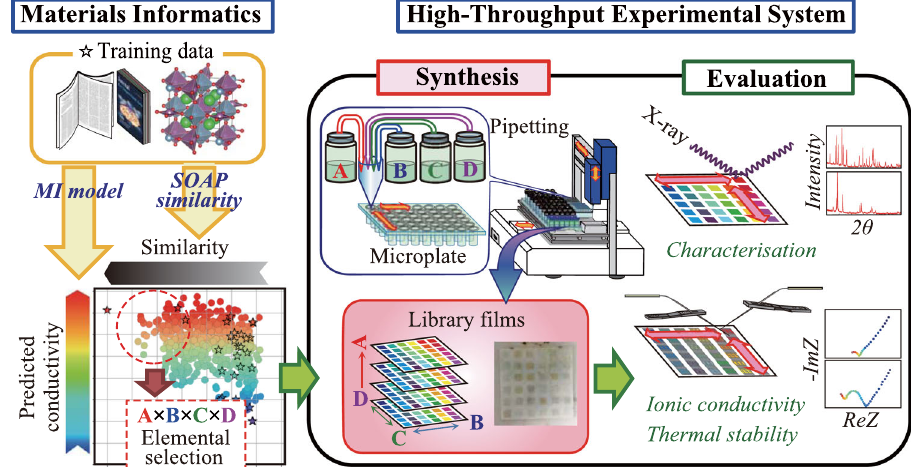
Fig. 1 Overview of the high-throughput screening approach. Materials Informatics proposes elemental combinations for which high-throughput experimental system identi fi es new and good superionic conductors. The fi lm libraries are prepared with an automatic pipetting system. Their crystal phases are identi fi ed via high-throughput XRD analysis at the SPring-8 synchrotron radiation facility. The conductivity and thermal stability of the compounds are evaluated with the high-throughput conductivity measurement